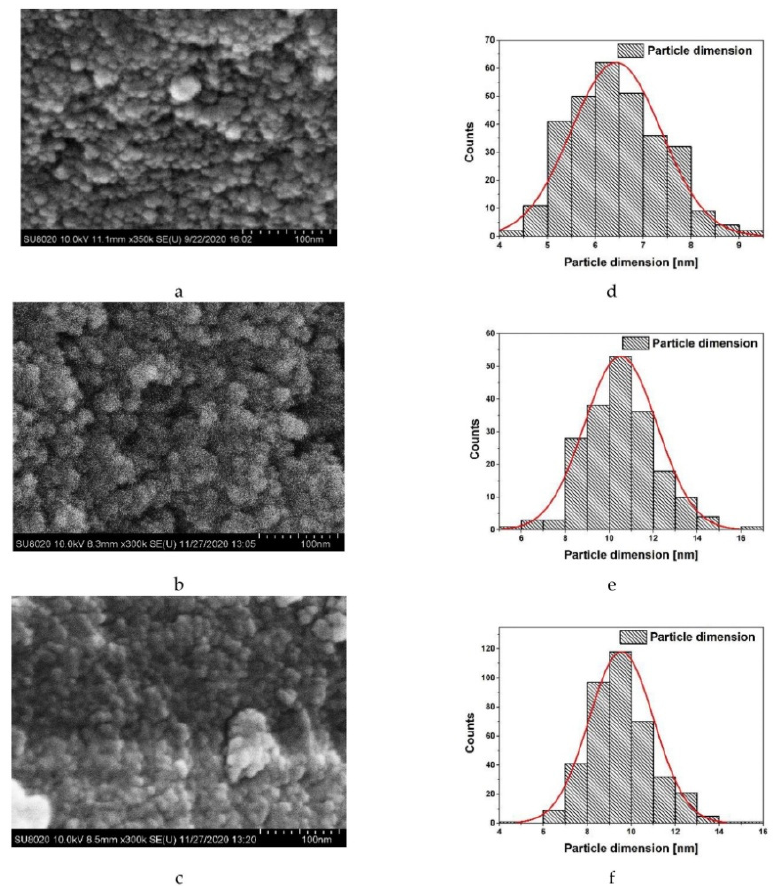
Figure 1. SEM image of particles obtained with a FESEM SU-8020 Hitachi instrument: ferrihydrite nanoparticles (Fh-NPs) ( a ); Co-Fh-NPs ( b ); Cu-Fh-NPs ( c ); particle size distribution hystogram and normal size distribution curve for each case ( d ), ( e ), and respectively ( f ).